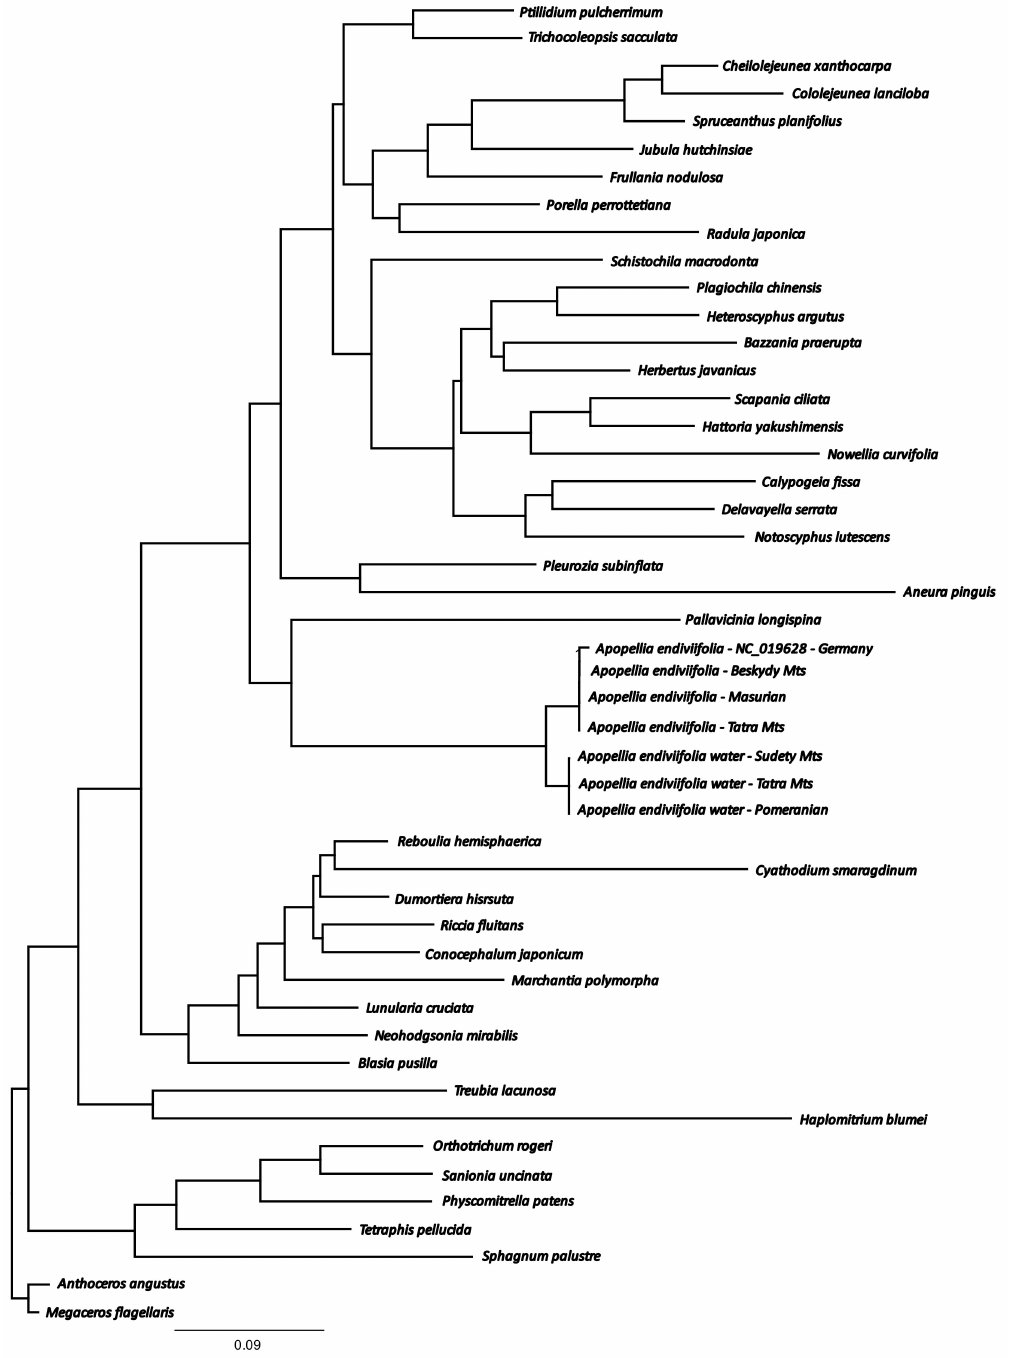
Figure 4. Phylogenetic relationships of liverworts based on protein-coding sequences obtained using Bayesian inference. All resolved clades have maximal posterior probability